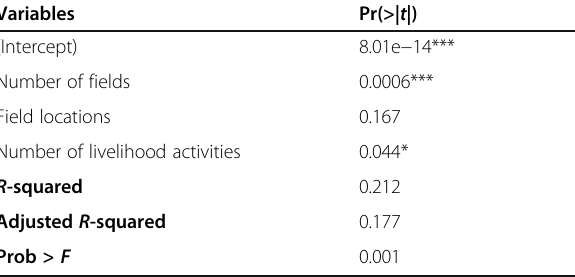
Table 5 Herd survival regression parsimonious model